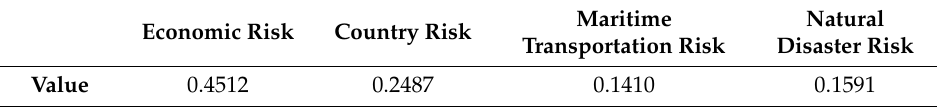
Table 8. Fuzzy analytic hierarchy process (AHP) results.